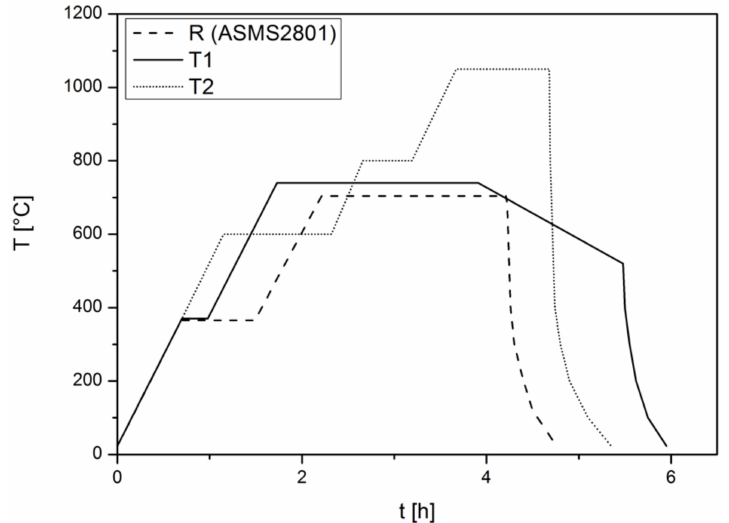
Figure 2. Temperature vs. time plots for the investigated post-processing T1 (740 ◦ C), T2 (1050 ◦ C) and R (704 ◦ C) heat